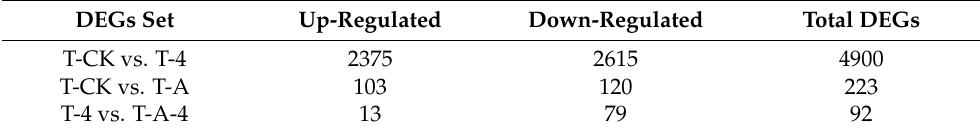
Table 4. Overview of DEGs in three pairwise